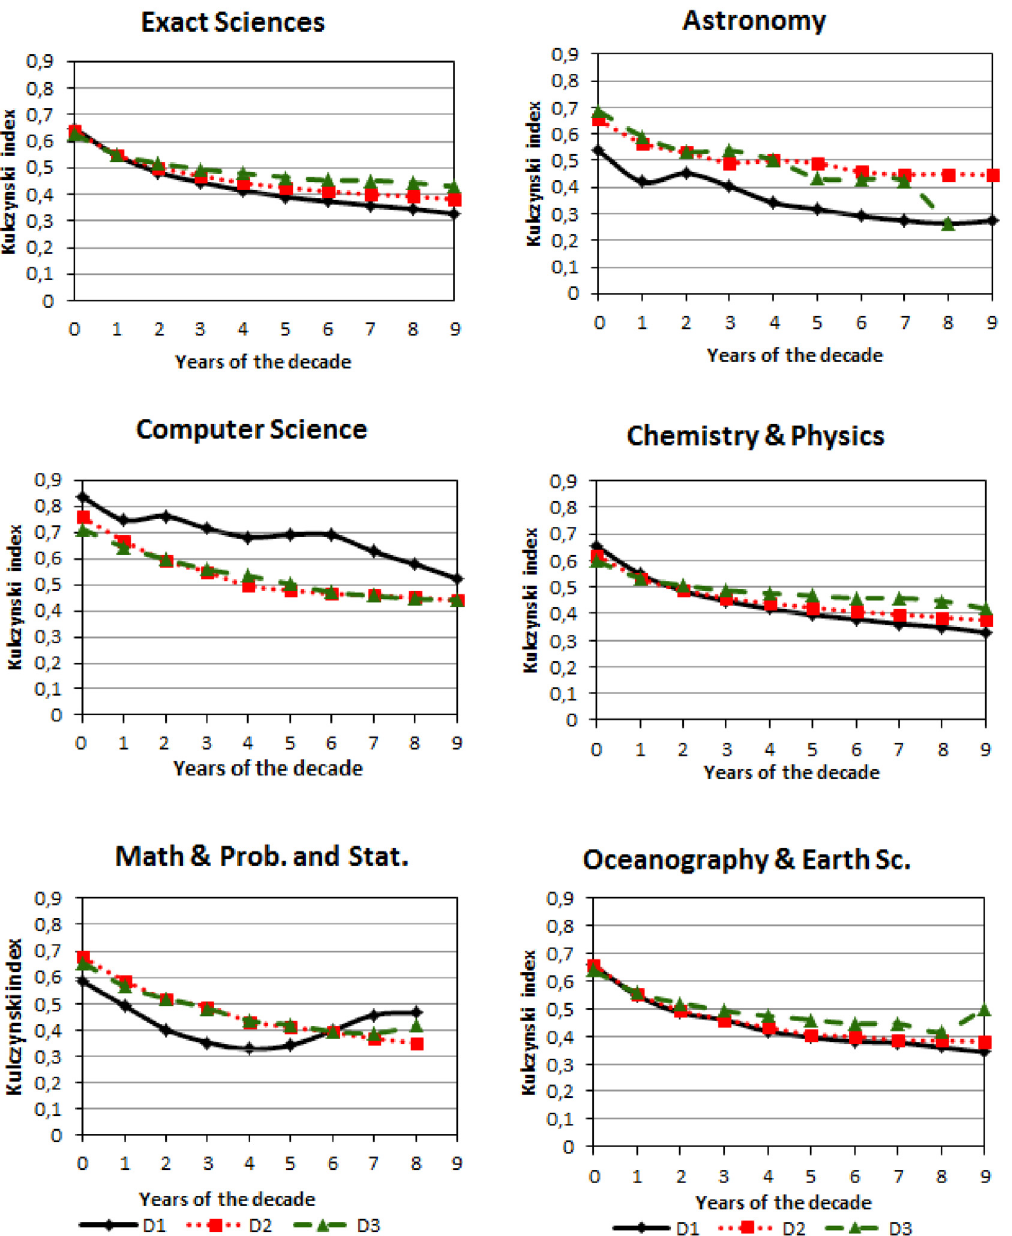
Fig 7. Mean of the Kulczynski index for decade D1, decade D2 and decade D3 for the Exact Sciences and the five clusters per subareas (according to the